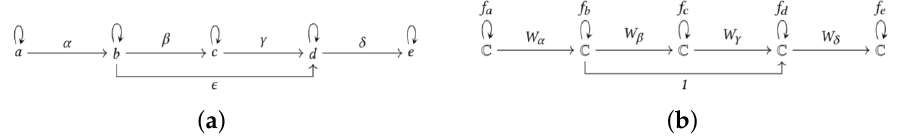
Figure 7. ( a ) Combinatorial architecture of a residual connection. ( b ) Weight architecture of a residual